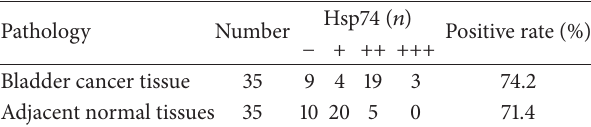
Table 1: Hsp74 expression in bladder cancer tissue and adjacent normal